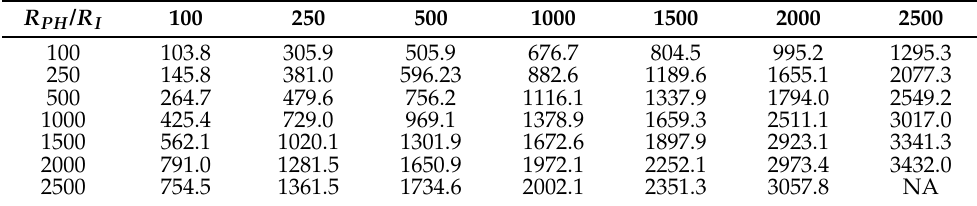
Table 4. Mean HP[kW] for the 243 maximum values.